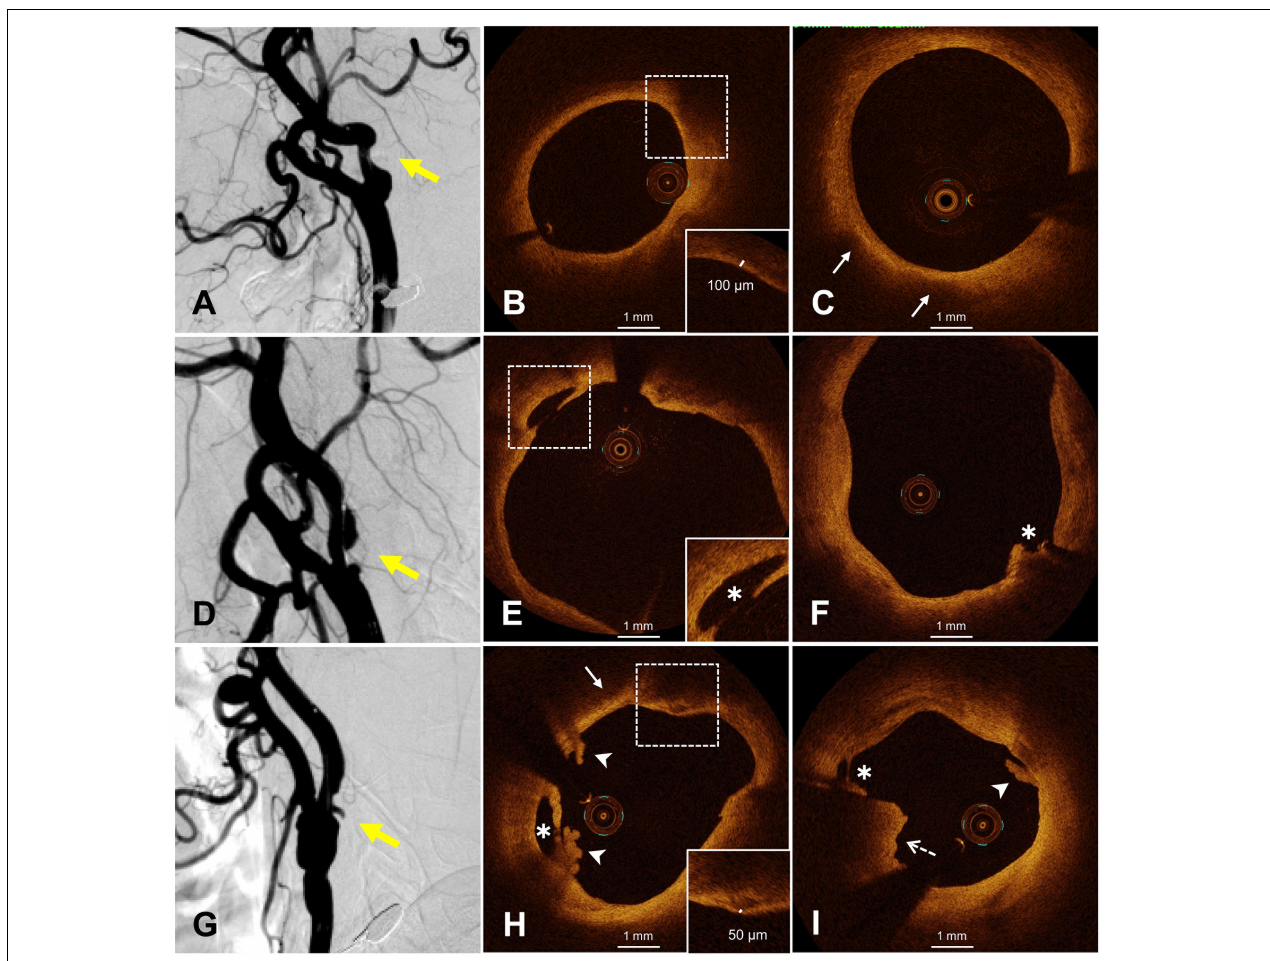
FIGURE 1 | Representative OCT images of smooth and irregular plaques. (A) Smooth plaque (yellow arrow), (B) fibrous cap thickness > 65 µ m (dotted frame), (C) lipid pool (white arrow), (D,G) irregular plaques, (E,F) plaque rupture (white asterisk), (H) white thrombus (white arrowhead), rupture (white asterisk), thin fibrous cap (dotted frame), lipid pool (white arrow), (I) white thrombus (white arrow), red thrombus (dotted arrow), and rupture (white asterisk). OCT, optical coherence tomography.